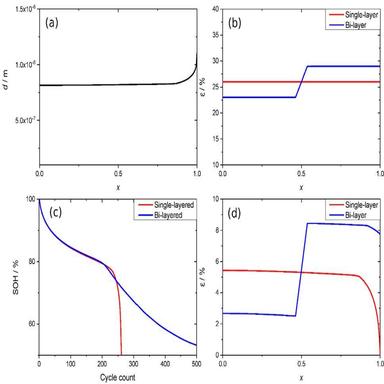
Simulated results from previous work . (a) Inhomogeneous thickness of the surface layer d, SEI and plated lithium, across the relative anode thickness x after sudden death. x = 0 demarks the boundary to the current collector and x = 1 the boundary to the separator. (b) Initial porosity profiles for the single and double layer anode. (c) State-of-Health (SOH) of single and double layer cell. Sudden death for the single layer cell after around 250 cycles, while no sudden death for the double laye